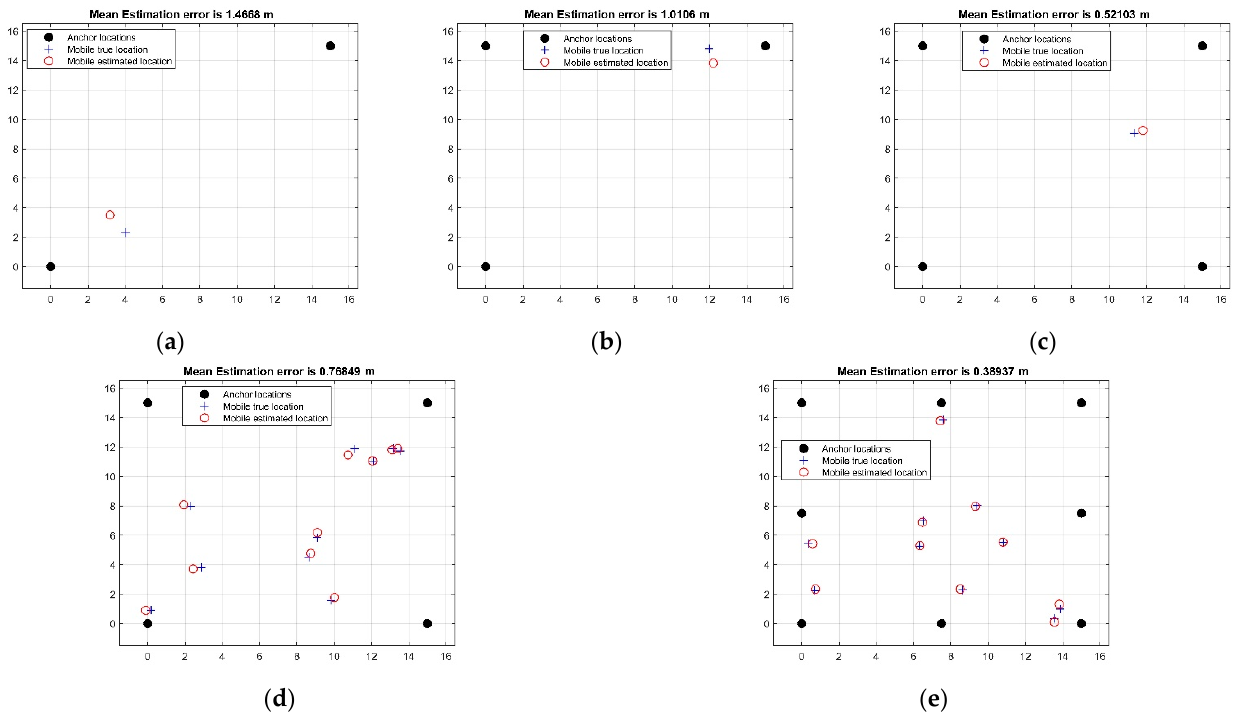
Figure 8. Localization results for C 1 C 1 and C 2 C 1 . ( a ) Localization estimation of one sensor node with two anchor nodes. ( b ) Localization estimation of one sensor node through trilateration. ( c ) Localization estimation of one sensor node through four anchor nodes (Multilateration). ( d ) Localization estimation of ten sensor nodes through four anchor nodes (Multilateration). ( e ) Localization estimation of ten sensor nodes through eight anchor nodes